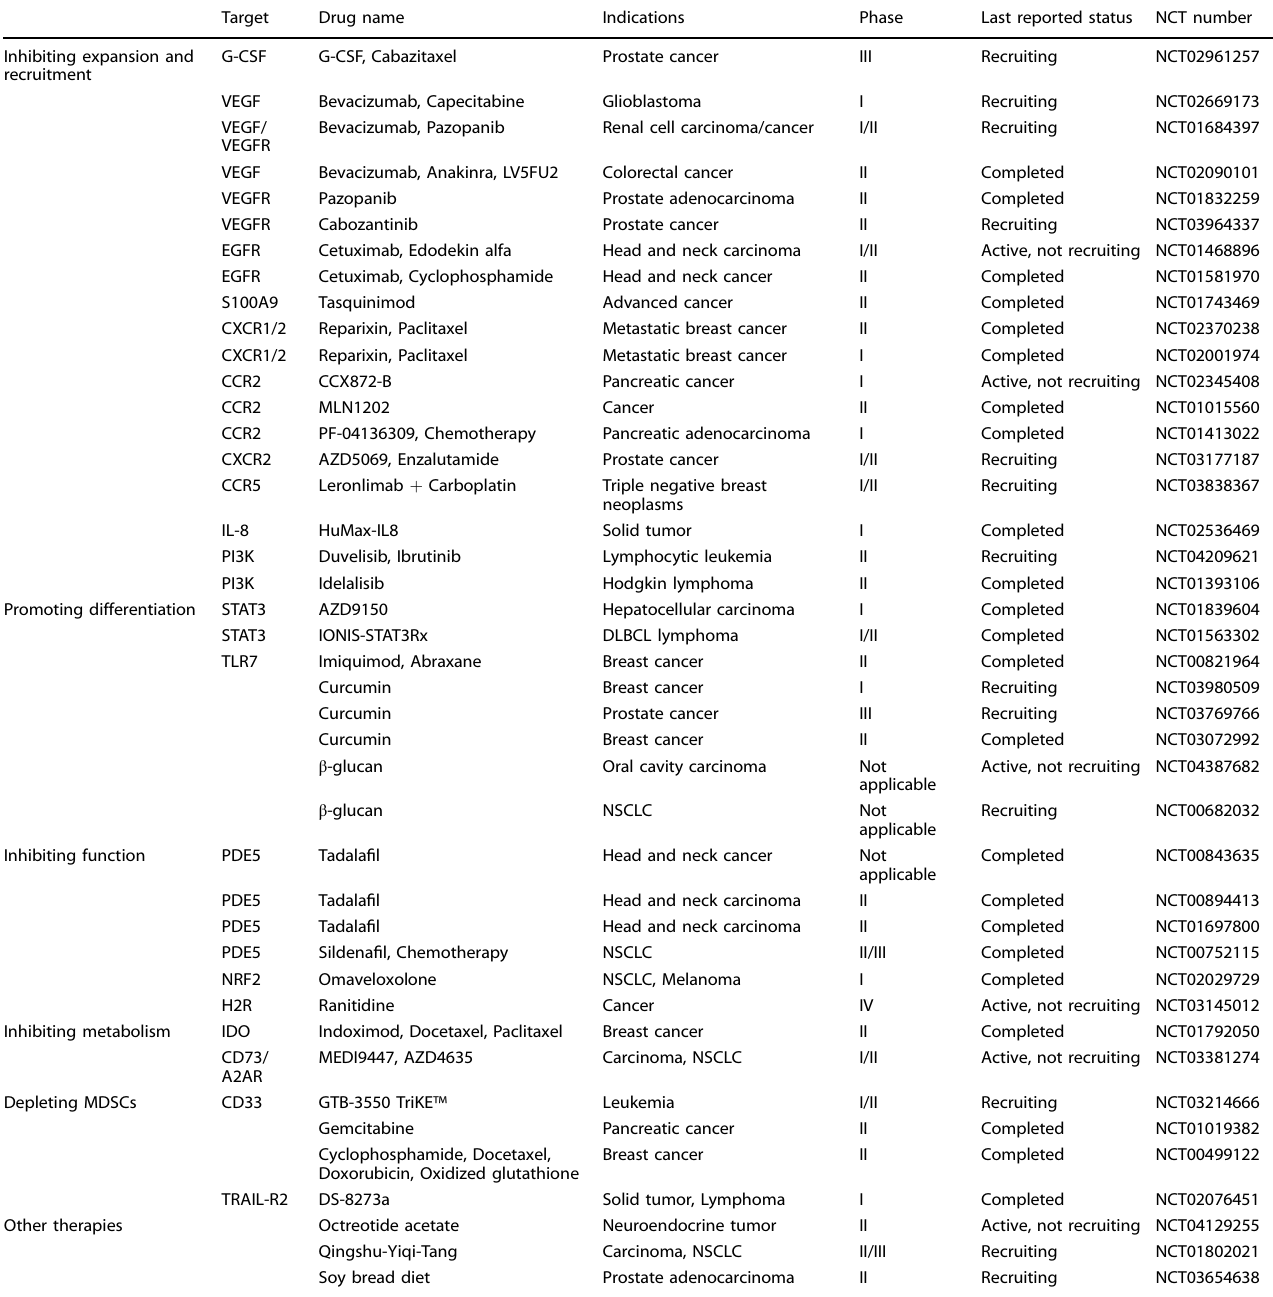
Table 1. Summary of clinical trials targeting MDSCs in